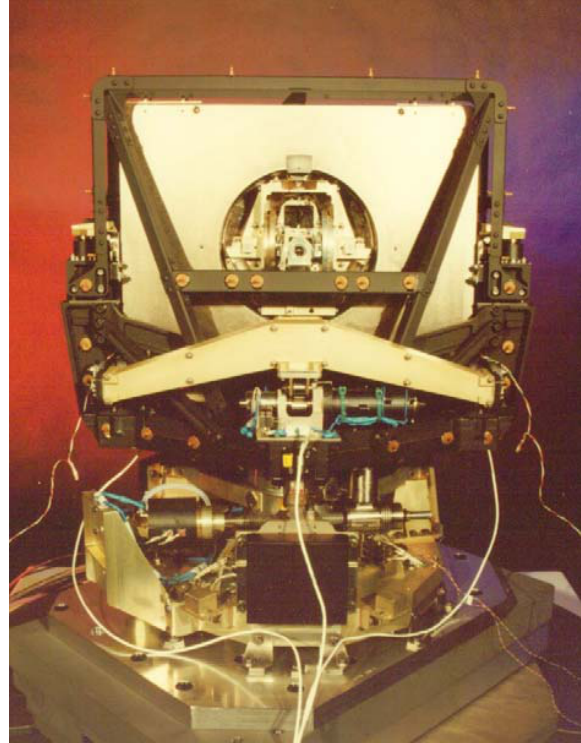
Fig. 5 : Steering Front Mechanism rear view. It moves the plane mirror in order to keep the image of the star always in the entrance slit of the spectrometers.